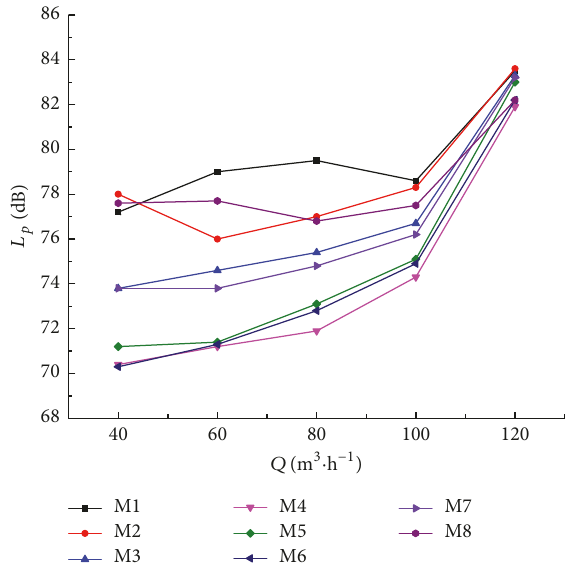
Figure 11: Sound pressure level under different flow